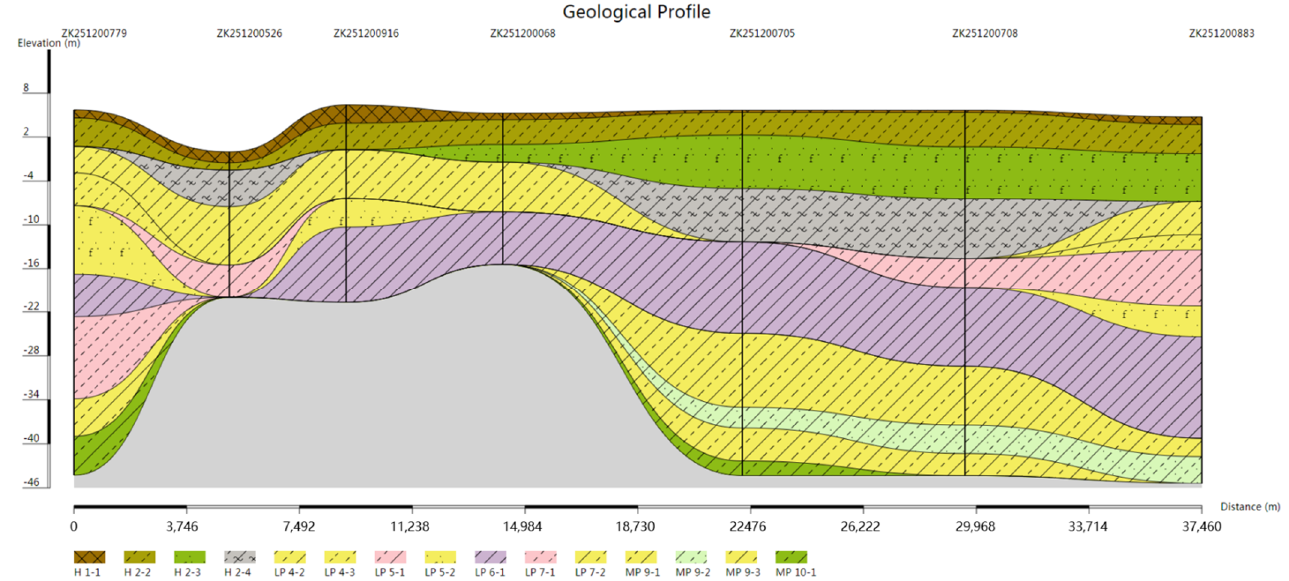
Figure 9. Geological profile III corresponding to drilling line III in Figure 7 by unique path method.